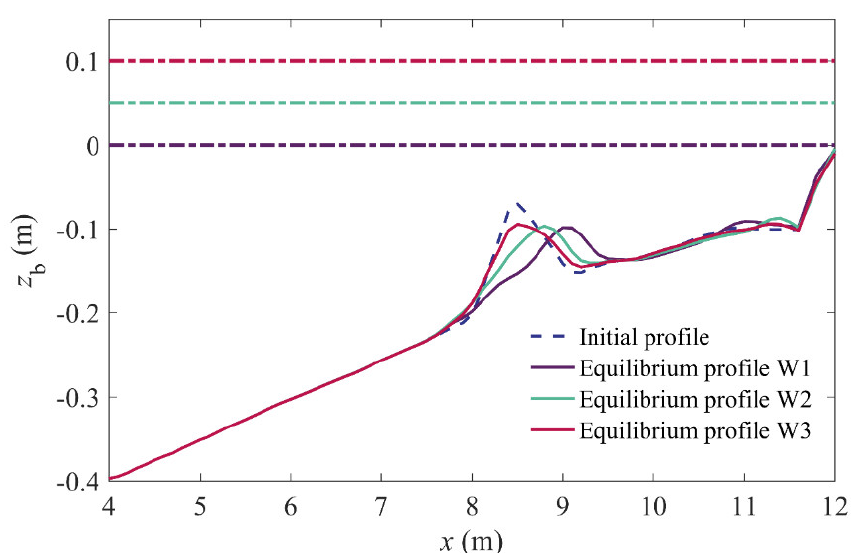
Figure 14. Equilibrium profile of the shoreface nourishment with different still water levels. Water level for each case is represented by the dash-dotted line in the same color.